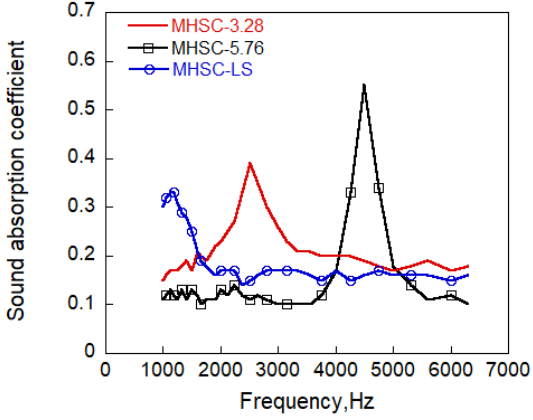
Figure 8. The sound absorption coefficient of MHSCs.